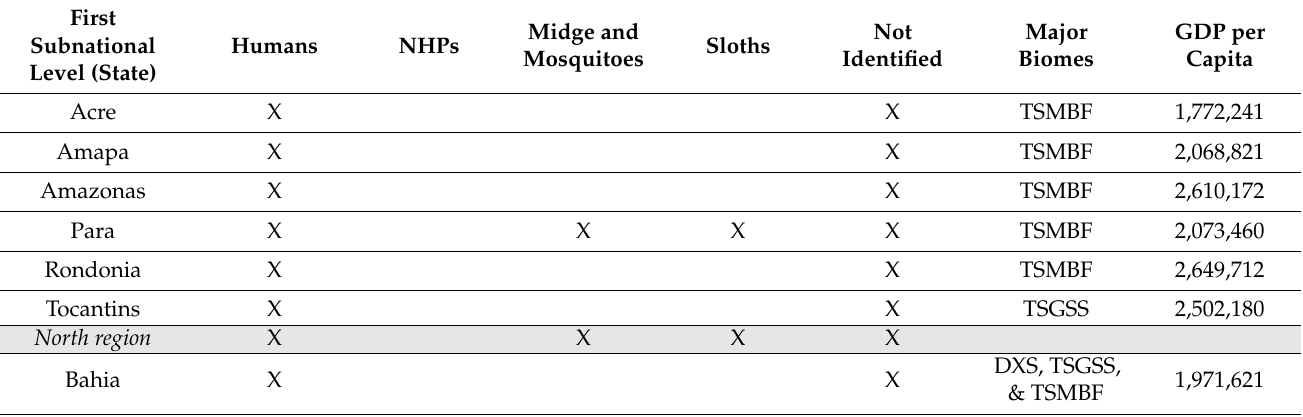
Figure 2. Oropouche virus presence by species over biome, by municipality, Brazil, 1960 to 2018. Table 2. Evidence of the presence of Oropouche virus by species, biome, and GDP per capita, by first subnational level, Brazil